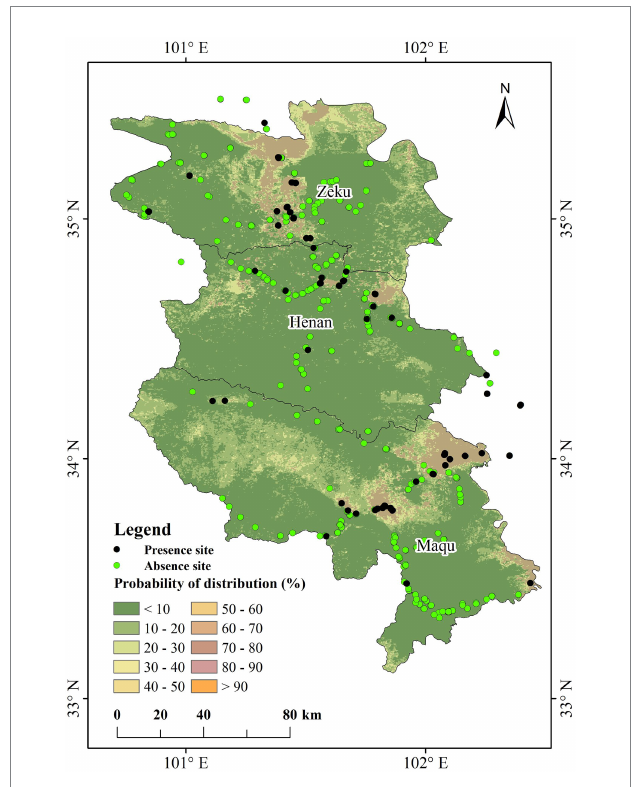
FIGURE 5 Distribution of presence probability of Kobresia pygmaea